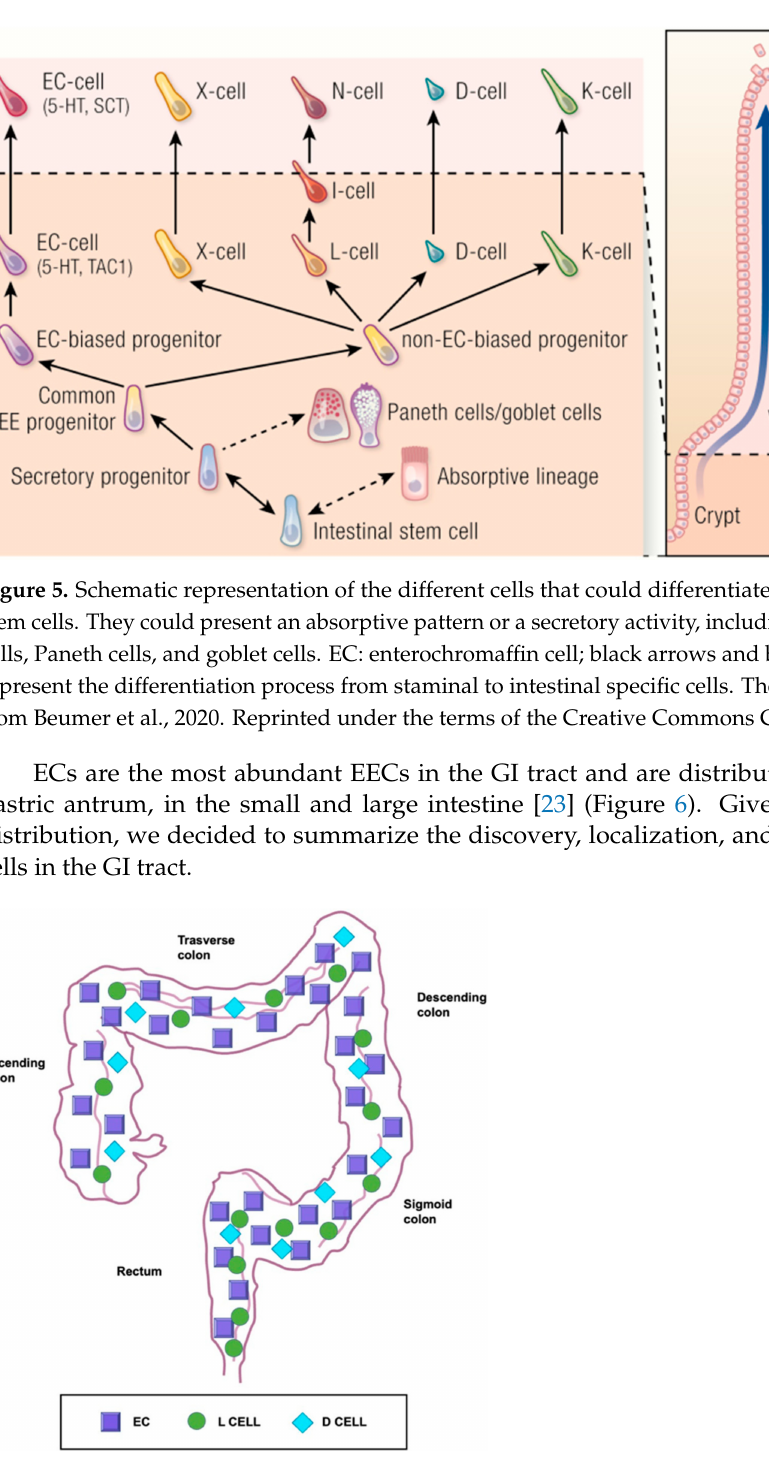
Figure 6. Schematic representation of the different distribution of enteroendocrine cell subtypes. They are the most abundant enteroendocrine cell subtype of the colon and rectum. D cells are scattered evenly throughout the GI tract, even if they are uncommon. The frequency of L-cells, instead, increases from proximal to distal being most concentrated in the rectum. EC: enterochromaffin cell. Modified from Gunawardene et al., 2011